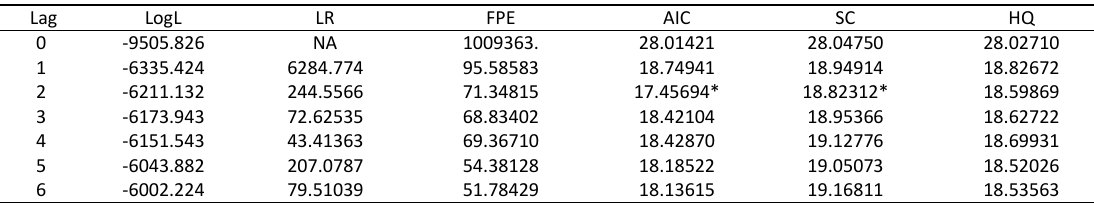
Table 2: VAR model for optimal lag selection